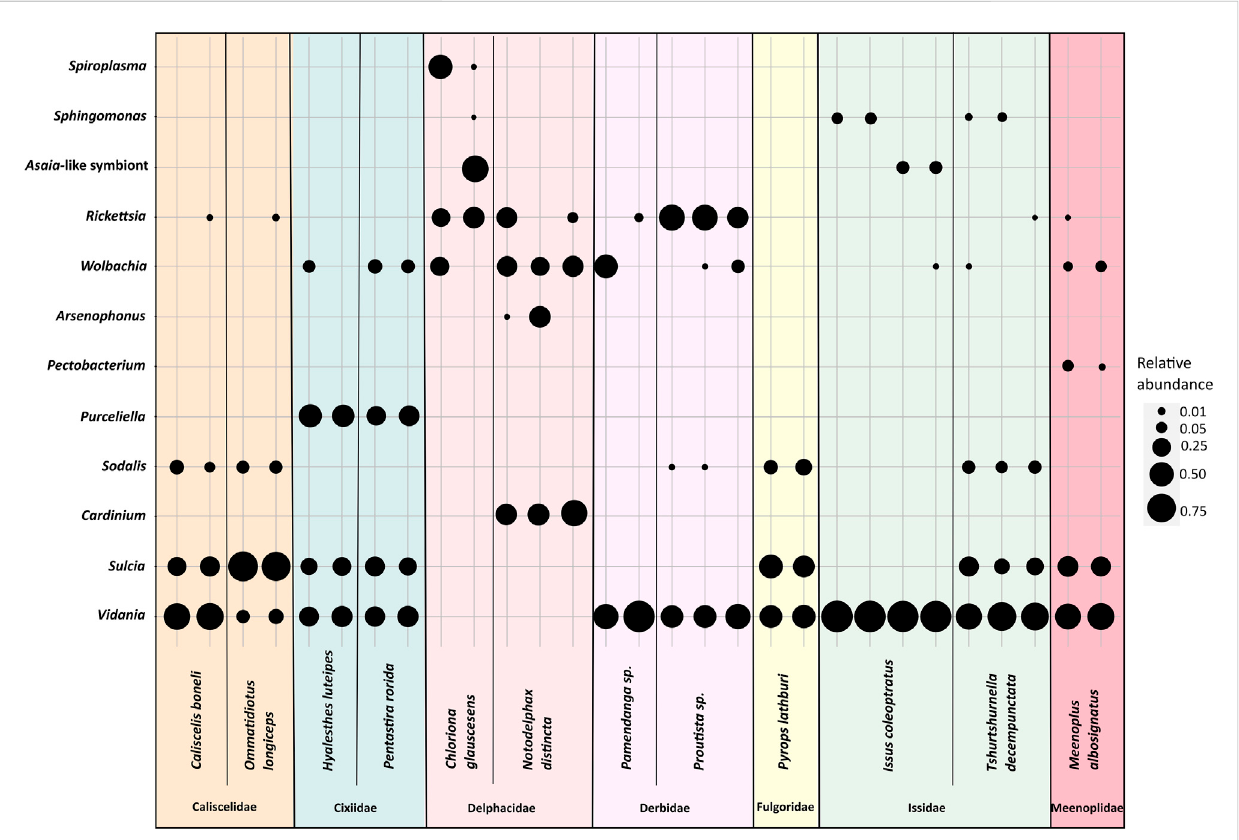
Thediversityofbacterialsymbiontsinreplicateindividualsofselectedplanthopperspecies.Theblobsizescorrespondtotherelativeabundanceofa symbiont from a given bacterial genus.